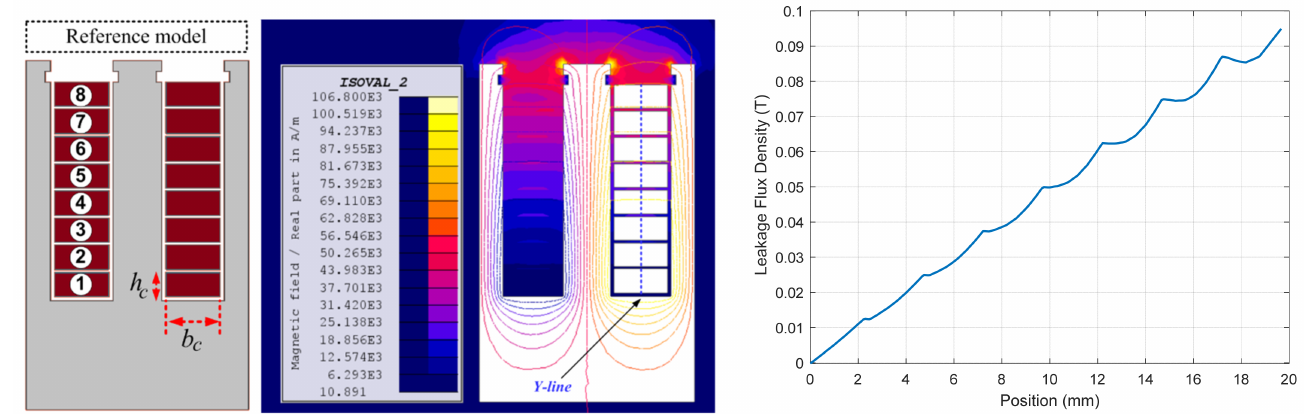
Figure 3. Modeling of a two-slot motorette at the strand level and estimation of the cross-slot leakage flux at high